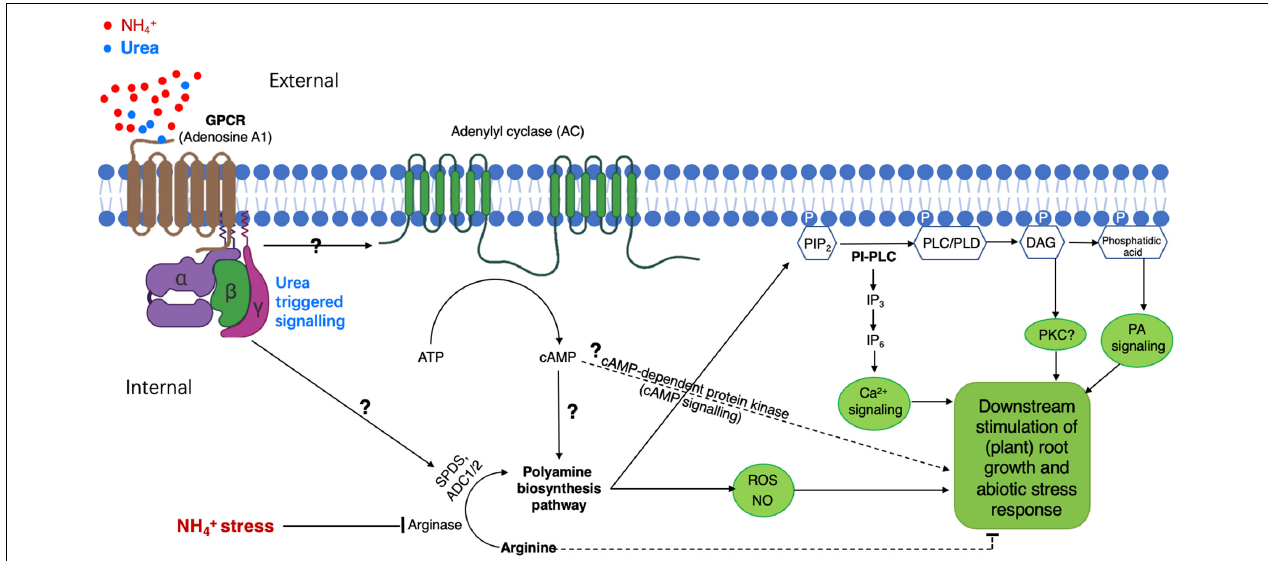
FIGURE 2 | A proposed model of PA-participated signaling pathway in plants for urea-elicited alleviation of ammonium stress. Heterotrimeric guanine nucleotide-binding proteins (G-protein) anchor to the inner leaflet of the plasma membrane and are coupled to a putative G-protein-coupled receptor (GPCR) specific for external urea. The GPCR recognizes and binds to urea, leading to its conformation change for the activation of the G-protein(s), by which a membrane-bound adenylyl cyclase (AC) is activated to generate a second messenger cAMP. Increased cAMP activates downstream some unknown molecular component(s) to eventually modify biosynthesis pathways for PA production; the increased cAMP might also activate cAMP-dependent protein kinase to directly modulate the stress response. The subsequent activation of phospholipase C or D (PLC or PLD) by PAs promotes the generation of PIP2-derived signal molecule IP3/DAG and/or phosphatidic acid in the cytosol, resulting in the activation of an unknown inner membrane ion-channel(s) for Ca 2 + release. An increase in cytosolic Ca 2 + will initiate different cellular processes for specifically regulating plant growth and development under given conditions, e.g., NH 4 + -stress with the presence of urea. This model postulated for PA-involved urea-antagonized NH 4 + -stress is based on our recent findings (Ke et al., 2020; Liu et al., 2021) and intensive surveys of related publications cited in this study. PIP2, phosphatidylinositol 4,5-bisphosphate; IP3, inositol-triphosphate; DAG,